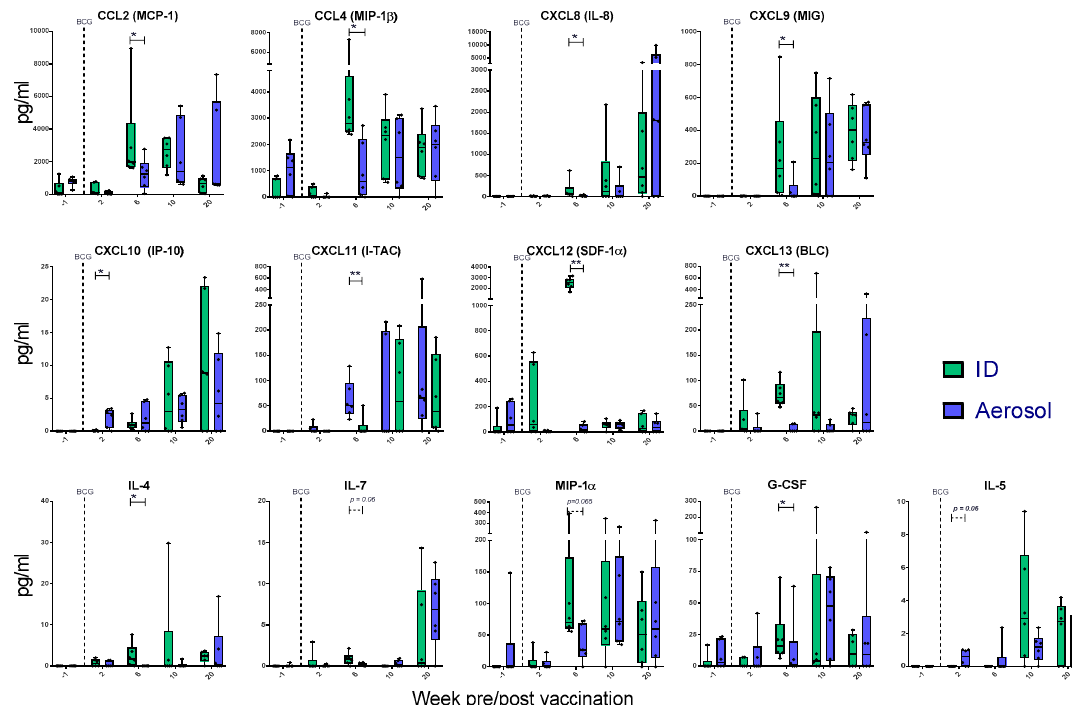
Figure 9. PPD-specific secretion of cytokine and chemokine biomarkers measured in whole blood culture supernatant. Box plots display the group median titre of each cytokine or chemokine +/- interquartile range measured prior to (-1) and at weeks 2, 4, 10 and 20 following vaccination. Dots represent titres measured in individual animals with the group minimum and maximum values shown by whiskers. Significant differences measured by Mann–Whitney U-test between the groups are indicated.